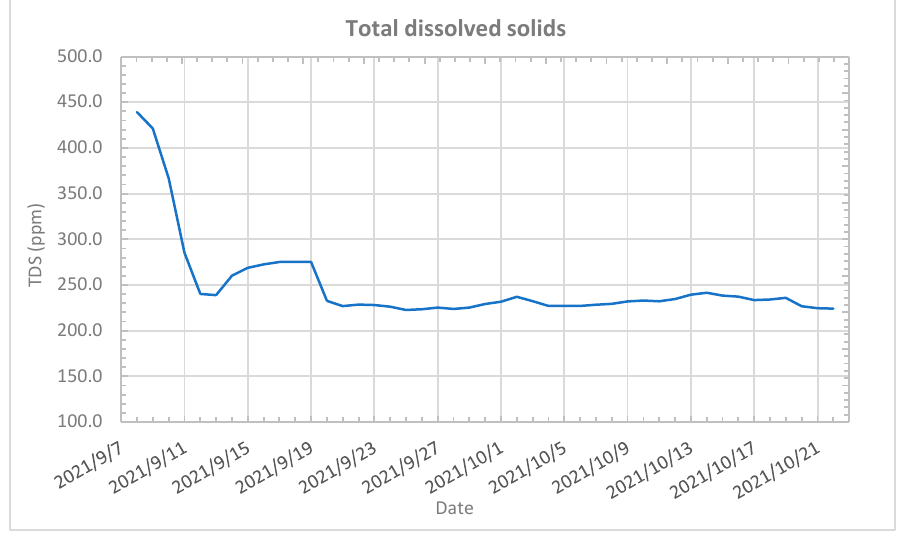
Figure 18. Salinity reduction by mixing the desalinated water with tap water.